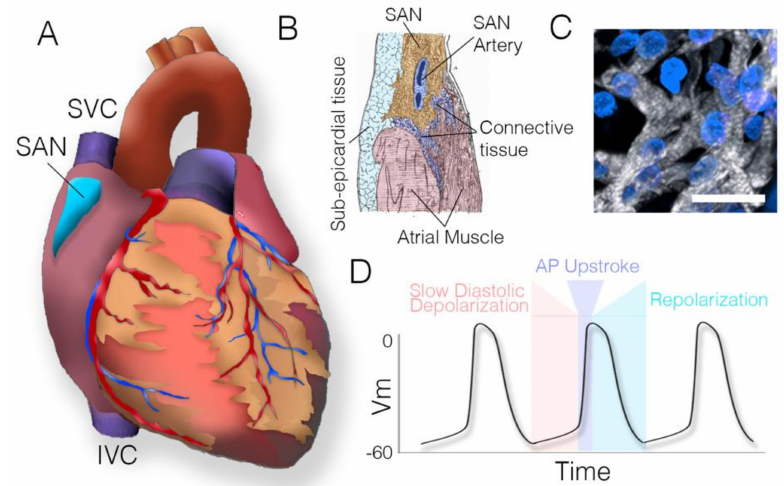
Figure 1. Anatomy and physiology of the sinoatrial node. ( A ) Diagram of the heart indicating the location of the sinoatrial node (blue). SAN—sinoatrial node, SVC—superior vena cava, IVC—inferior vena cava. ( B ) Sketch of sinoatrial node structure (modified from Keith and Flack 1907 [2]). Pacemaker myocardium (yellow) surrounds the sinoatrial node artery and is infiltrated and surrounded by connective tissue. ( C ) 30mm Z-stack through the sinoatrial node of an avian embryo. Pacemaker myocardium stained with MF20 (white) is arranged as loosely connected, unaligned fibers. Scale bar—20 mm. ( D ) Pacemaker cell action potential waveform. Vm—membrane